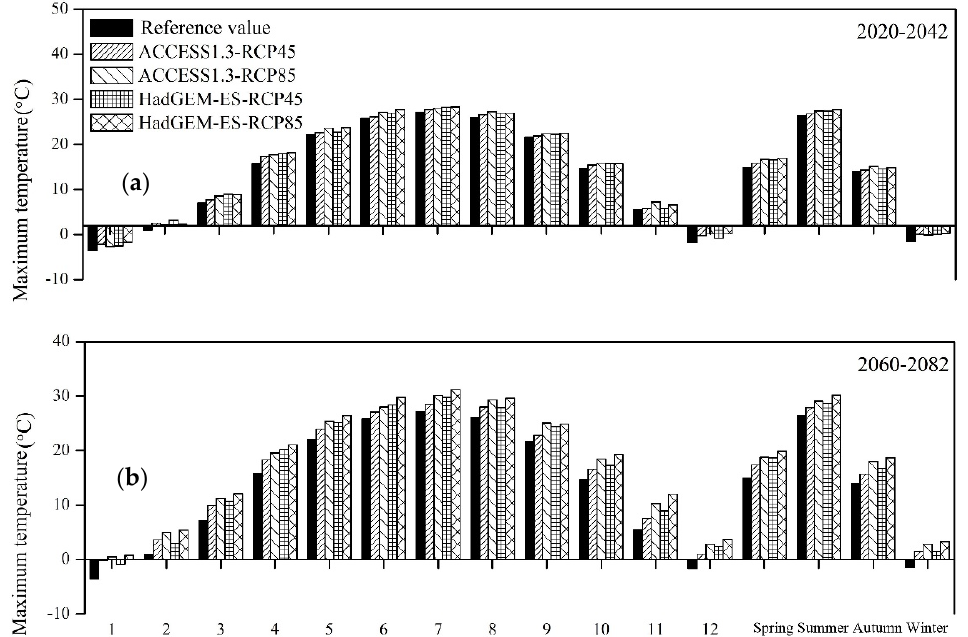
Figure 4. Projected values of maximum temperature under the different combinations of GCMs and RCPs scenarios during the different assessment periods. ( a ) from 2020 to 2042; ( b ) from 2060 to 2082.